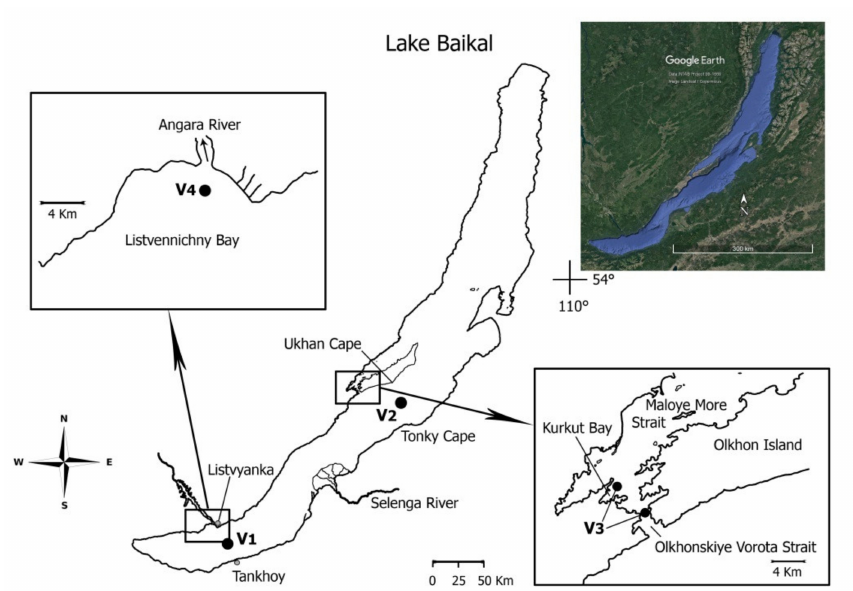
Figure 1. Lake Baikal and sampling sites (marked with a black circle). The lake shoreline contours and additional designations were reproduced using Google Earth Pro software (https://www.google.